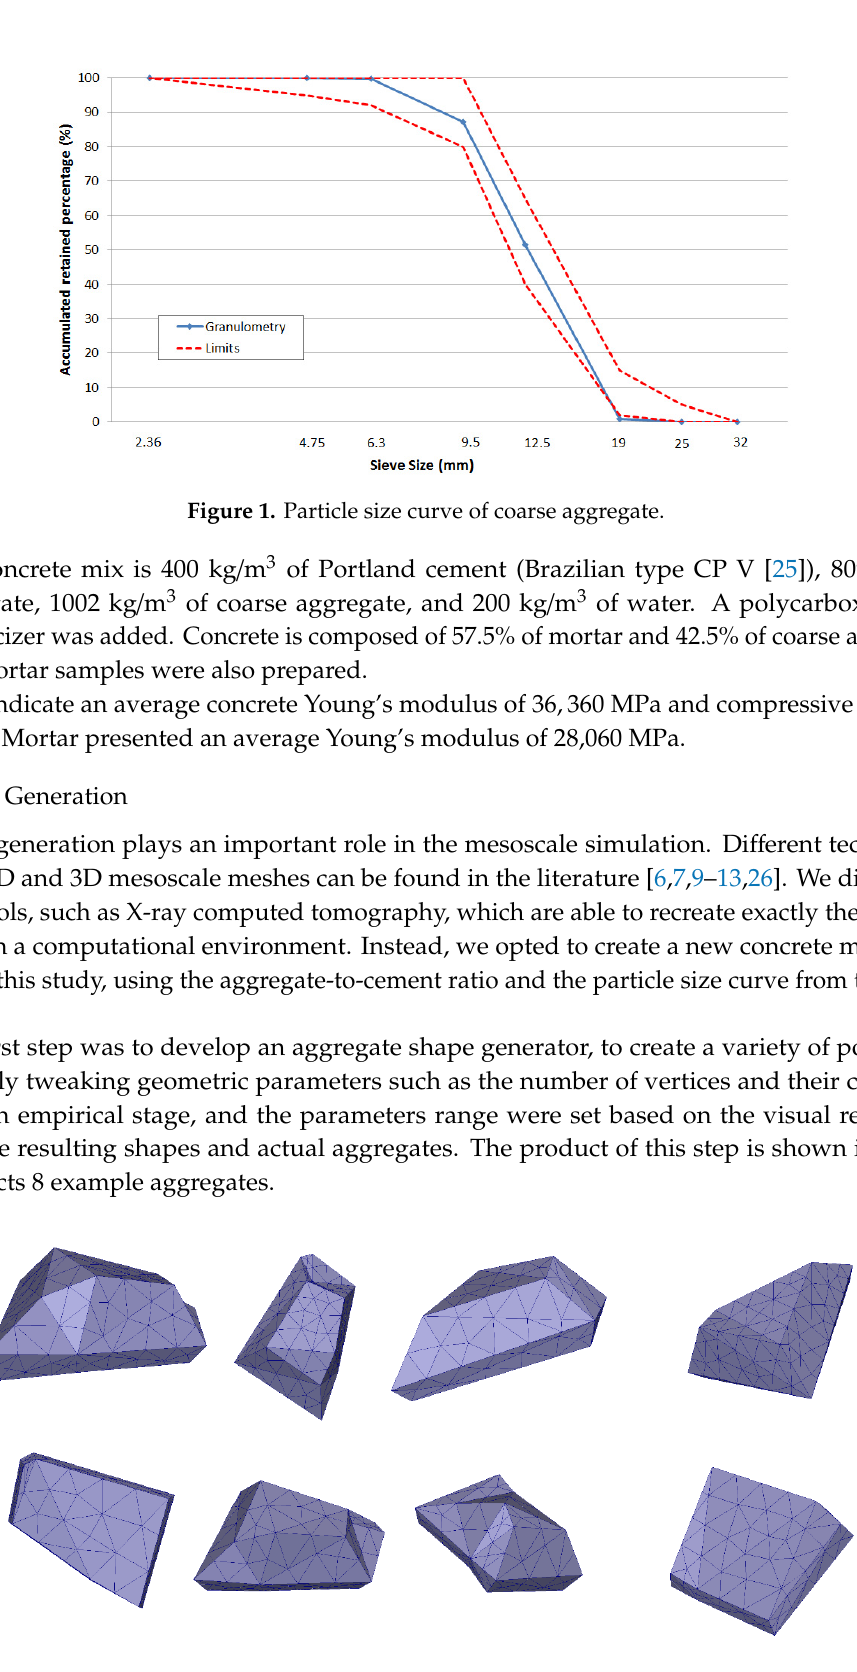
Figure 2. Example of randomly generated aggregate shapes.